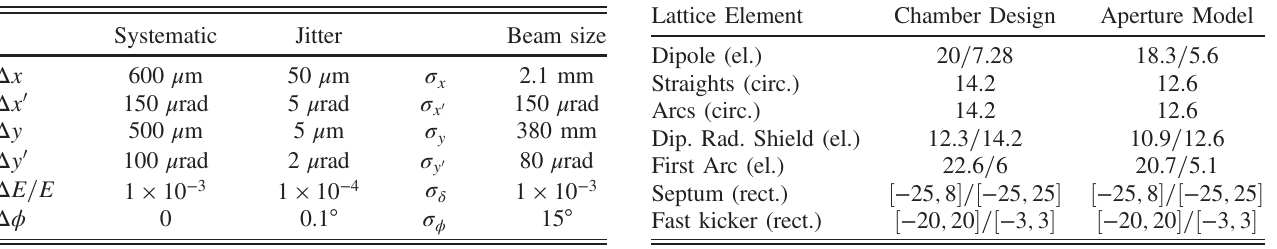
TABLE III. Accumulator ring injected-beam rms systematic and jitter errors and rms injected beam sizes.